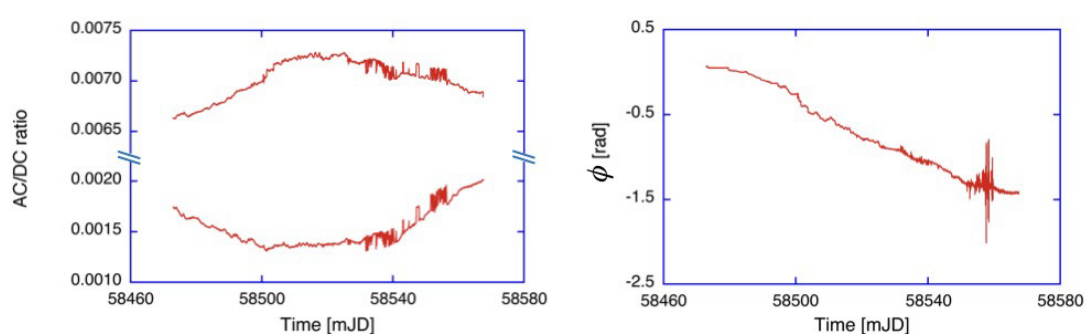
Figure 3. The parameters m 1 , m 2 and φ of the backscatter correction (Equation (4)) of a time series of about 100 days in length. Due to the mechanically monolithic construction of the G ring laser and the active pressure stabilized environment of the gyroscope, there are only small changes in the backscatter pulling observable.